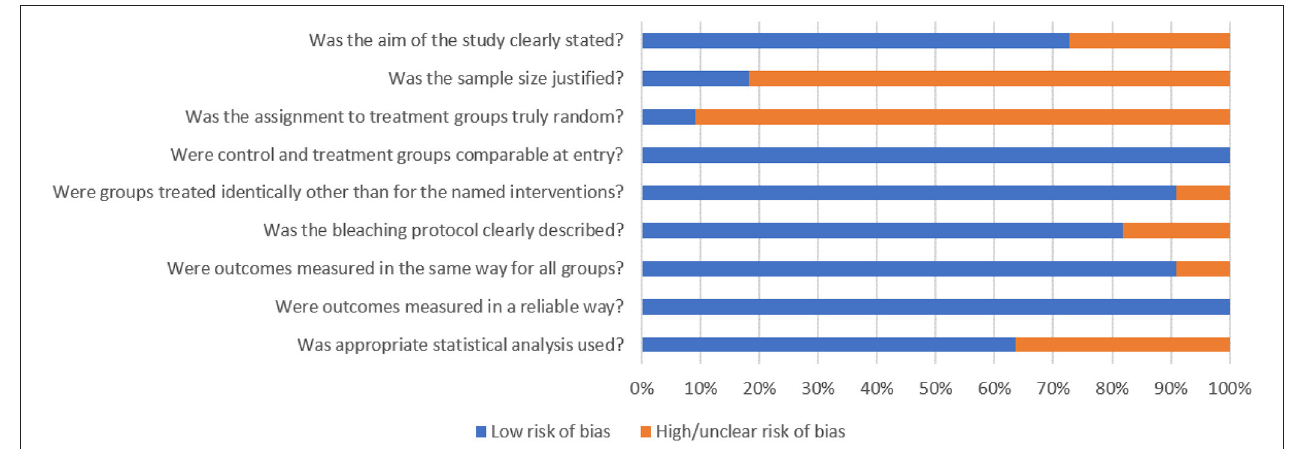
FIGURE 2 | Assessment of the risk of bias in the included studies according to the percentage of the scores attributed to each evaluated